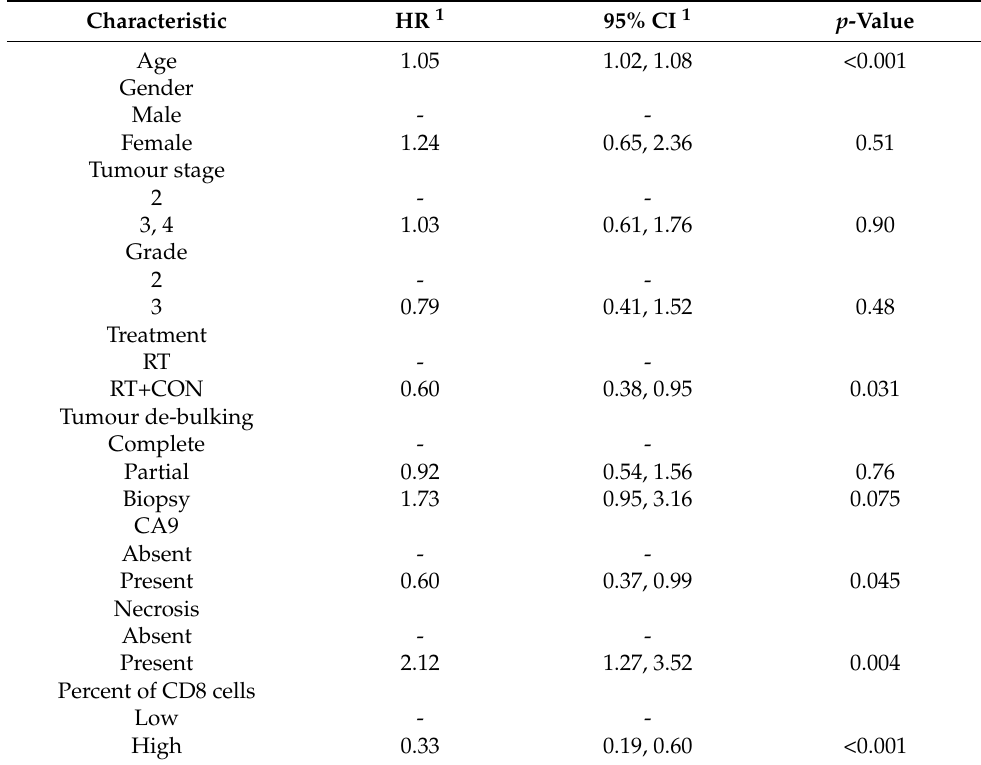
Table 1. Multivariable Cox proportional hazard model analyses of proportion of CD8 T cells alongside other clinicopathologic variables as calculated by “survival” and “gtsummary” packages in R. Characteristic HR 1 95% CI